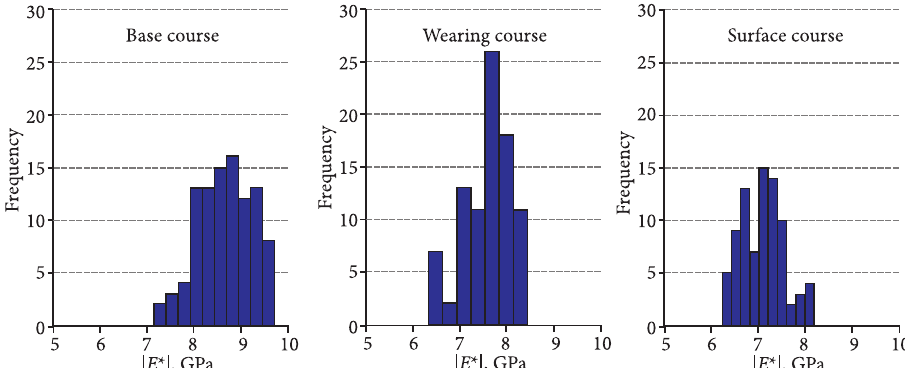
Fig. 5. Complex modulus value distribution | E *| ( T = 10 °C, f =10 Hz) determined experimentally (4PBBT) for beams cut-out from pavement test section asphalt layers